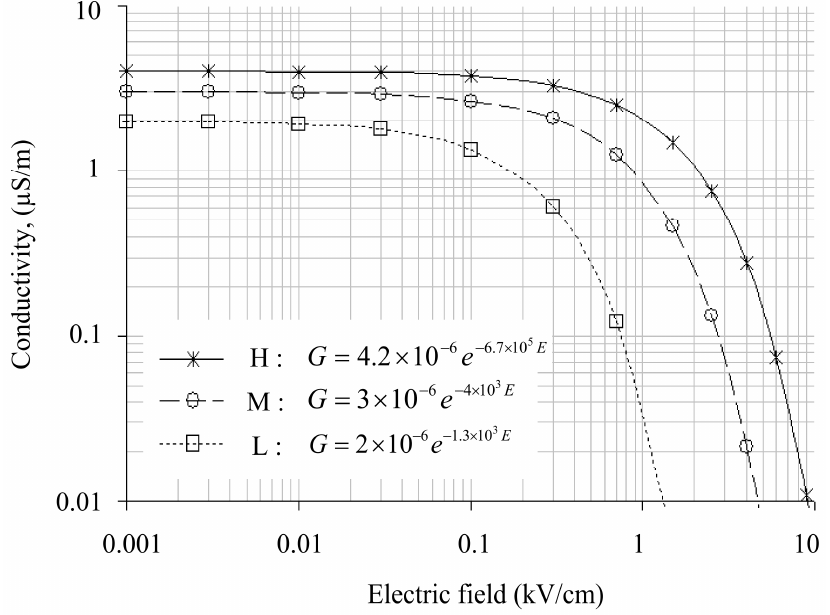
Figure 13. Field-conductivity relationship for the pollution model under light rain weather conditions (non-uniform wetting action).